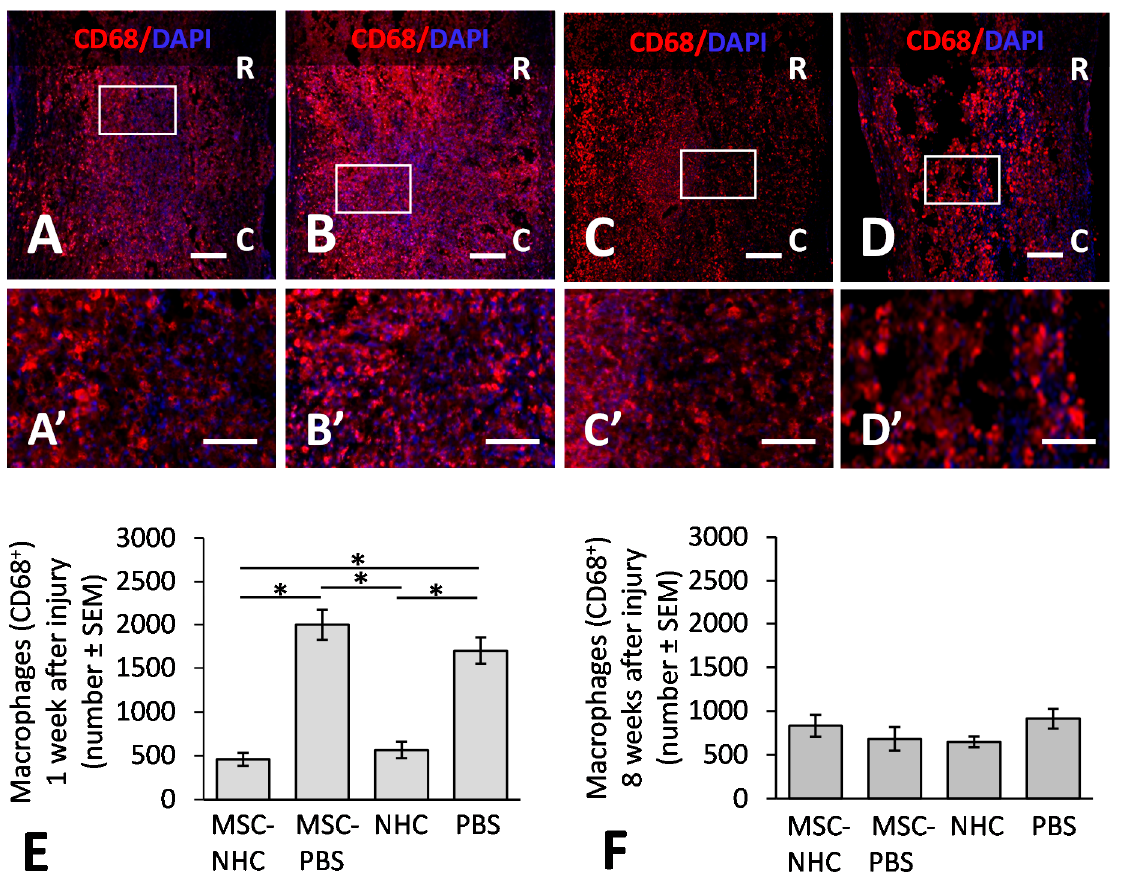
Figure 1. CD68 inflammatory response in the injury site. Photomicrographs showing macrophages stained for CD68 (red), a pan-macrophage marker, and the nucleus marker, DAPI (blue), in the injury site with MSC-NHC ( A ), MSC-PBS ( B ), NHC ( C ), or PBS ( D ) at 1 week after injury. Images in panels ( A’ – D’ ) are enlargements of the outlined area in panels ( A – D ), respectively. Scale bar in ( A , C , D ) is 250 µm, and 200 µm in ( B ). The scale bar in ( A’ – D’ ) is 100 µm. In ( A – D ), the rostral (R) and caudal (C) orientation of the horizontal sections are indicated. ( E ) Bar graph showing the average number of CD68+ macrophages in the injury site of each group at 1 week after injury. There are significantly less macrophages in the injury site with MSC-NHC and NHC only compared with MSC-PBS and PBS only. ( F ) Bar graph showing the average number of CD68+ macrophages in the injury site of each group at 8 weeks after injury. The differences in numbers of CD68+ macrophages in the injury site of the four groups were not statistically significant. In both graphs, the asterisks indicate p < 0.05, and the bars represent SEM. Abbreviations: DAPI = 4 ′ ,6-diamidino-2-phenylindole; MSC = mesenchymal stromal cells; NHC = nanofiber-hydrogel composite; PBS = phosphate-buffered saline; SEM = standard error of the